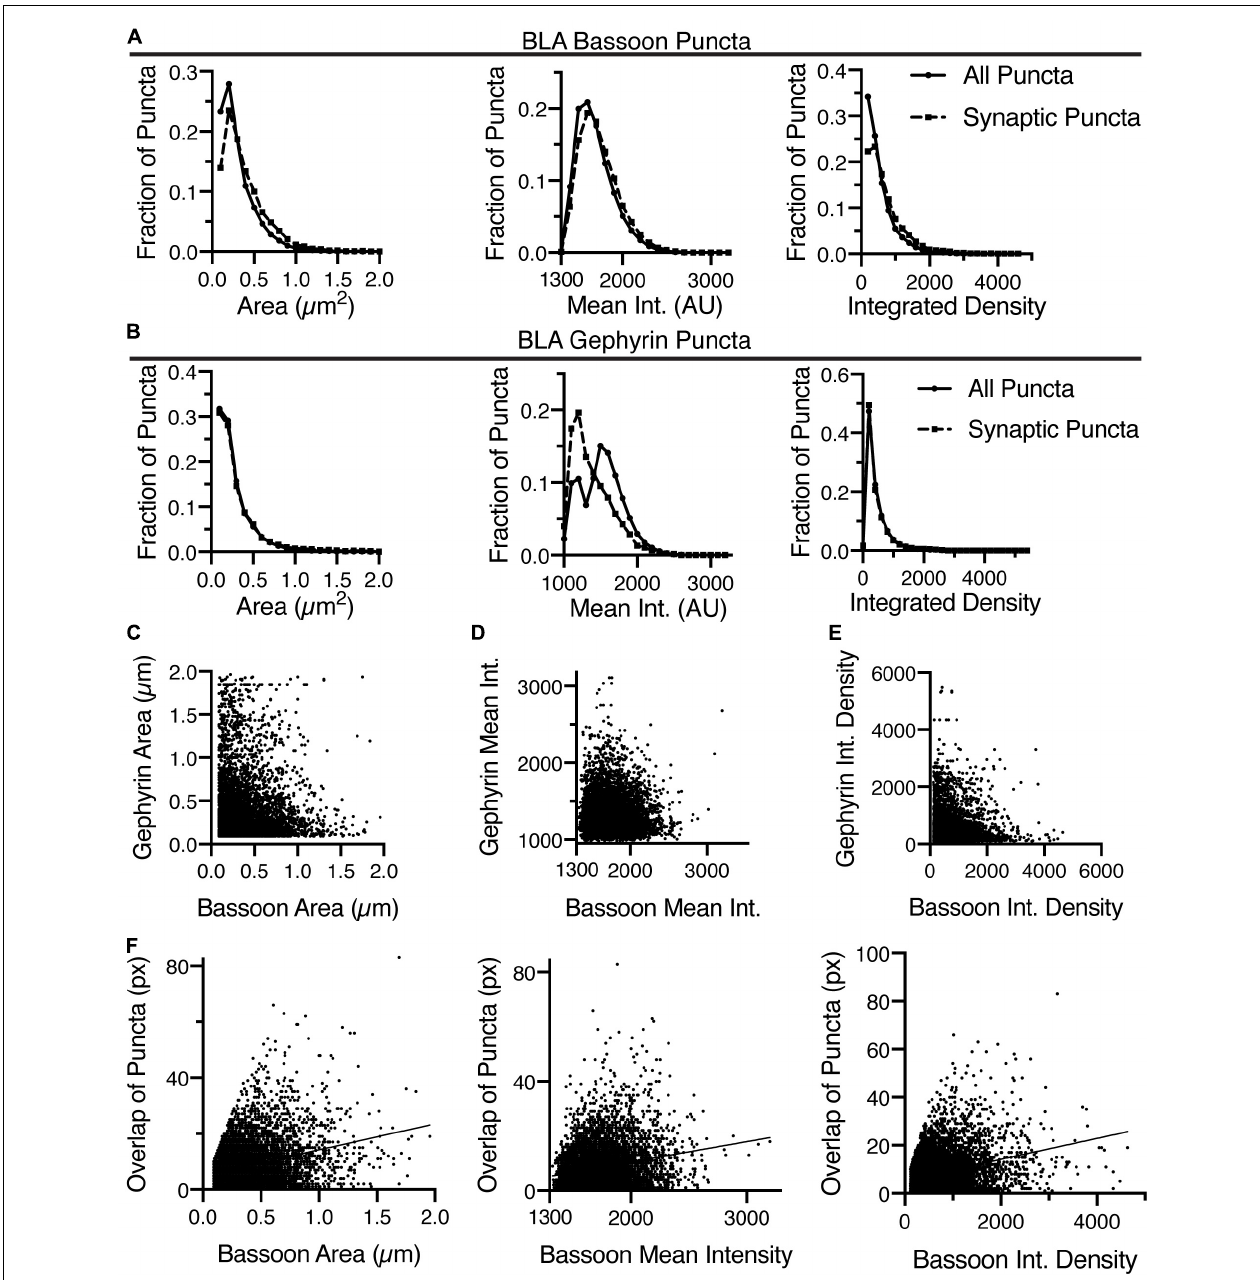
FIGURE 7 | Identification of overlapping bassoon and gephyrin puncta in the BLA enables detailed morphometric analysis. (A) In the BLA, the distribution of area, mean intensity, and integrated density of all bassoon puncta and synaptic bassoon puncta reveals changes in distribution. (B) Similarly, the distribution of area, mean intensity, and integrated density of all gephyrin puncta and synaptic gephyrin puncta in the BLA reveals changes in distribution. Identification of overlapping bassoon and gephyrin puncta enable correlation of area (C) , mean intensity (D) , and integrated density (E) . (F) Overlap between gephyrin and bassoon puncta is positively correlated with area, mean intensity and integrated density of bassoon puncta in BLA.